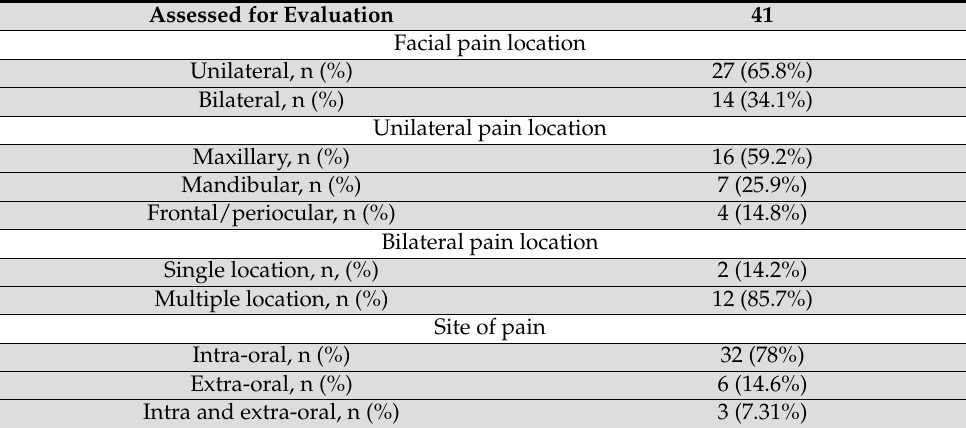
Table 3. Pain topography of PIFP population (41